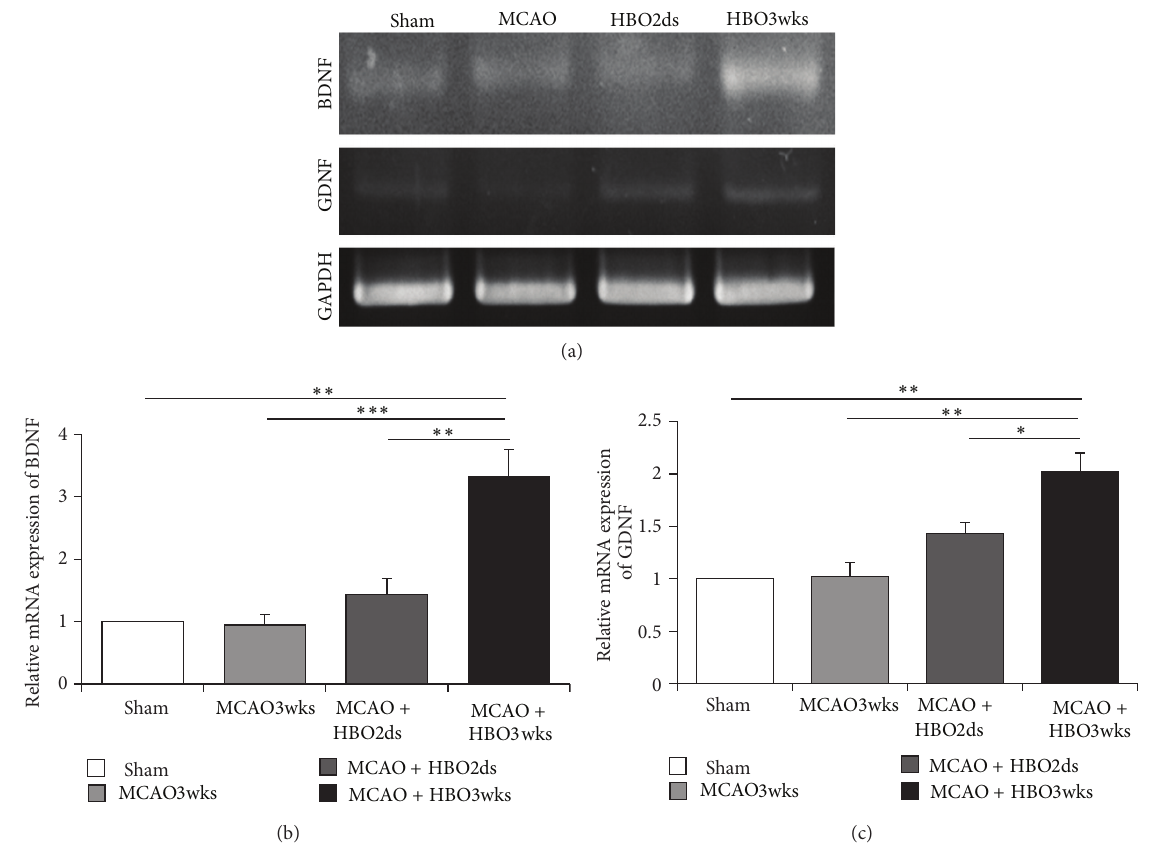
Figure 7: Long course HBO increased neurotrophic factor level. (a) The mRNA levels of BDNF and GDNF showed that mRNA expression levels were increased in HBO treatment group. ((b) and (c)) Expression levels of BDNF and GDNF were significantly increased in the HBO3wks group ( 𝑃 < 0.05